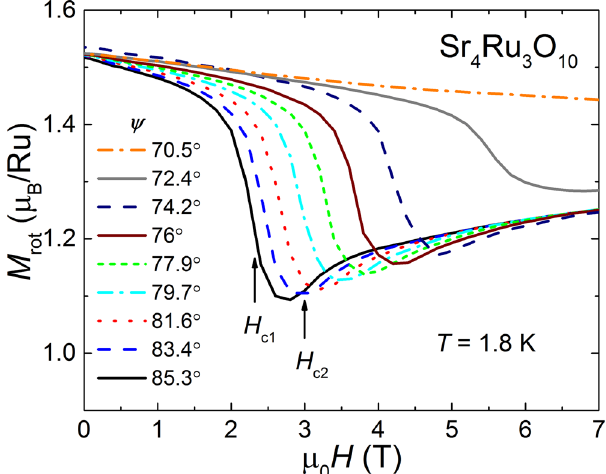
Figure 5. Magnetization modulus M rot in the rotational plane versus magnetic field H for angles ψ between 85.3° and 70.5° in decreasing fields. The drop in M rot coincides with H c 1 and the step-like increase with H c 2 as marked by arrows for the measurement at ψ =